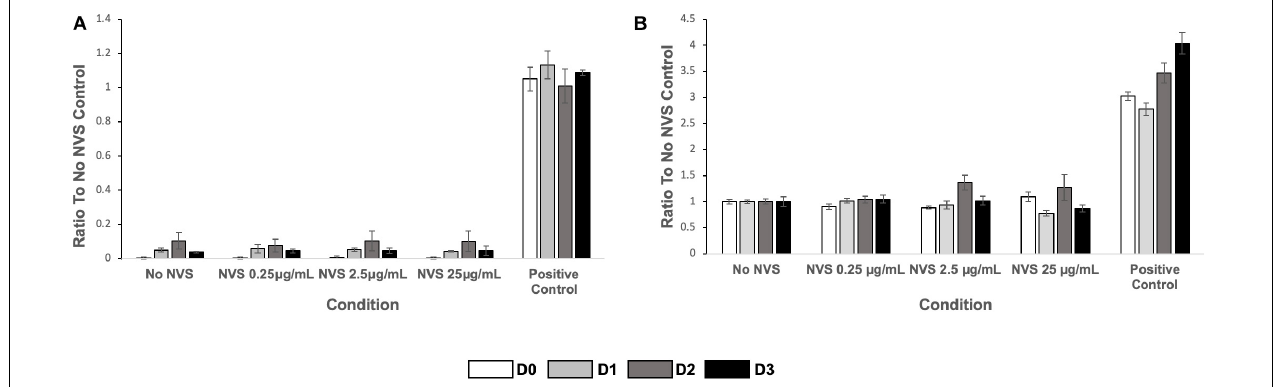
FIGURE 6 | Cell death. (A) HUVEC apoptosis (left) and (B) HASMC apoptosis (right) of cultured cells upon exposure to NVS. Results are presented as average ± standard deviation.